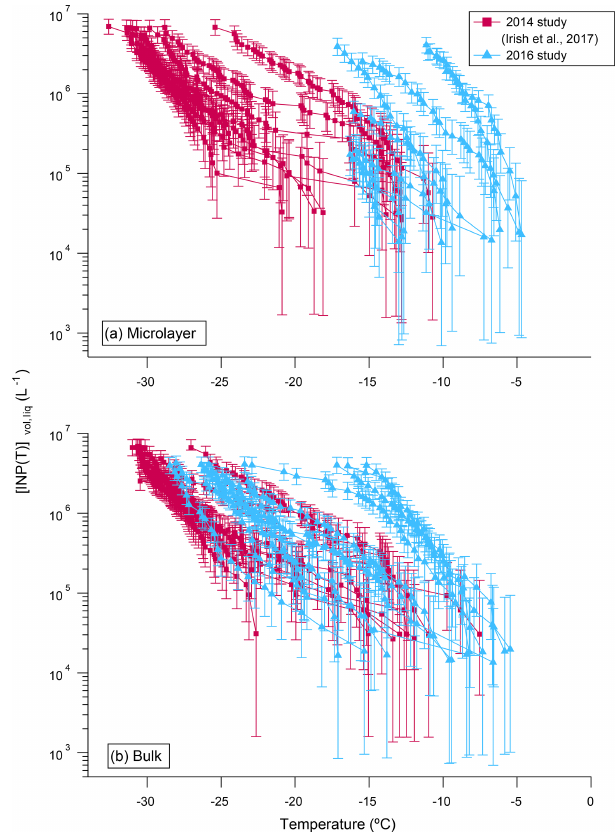
Figure 3. Comparison of the concentrations of INPs, [INP( T )] vol , liq , in (a) the microlayer and (b) bulk seawater samples from the 2014 (pink squares) and 2016 (blue triangles) studies. All data were corrected for freezing point depression. Error bars represent the statistical uncertainty due to the limited number of nucleation events observed in the freezing experiments (Koop et al., 1997). Only freezing data that were at warmer temperatures than the field blanks are included.